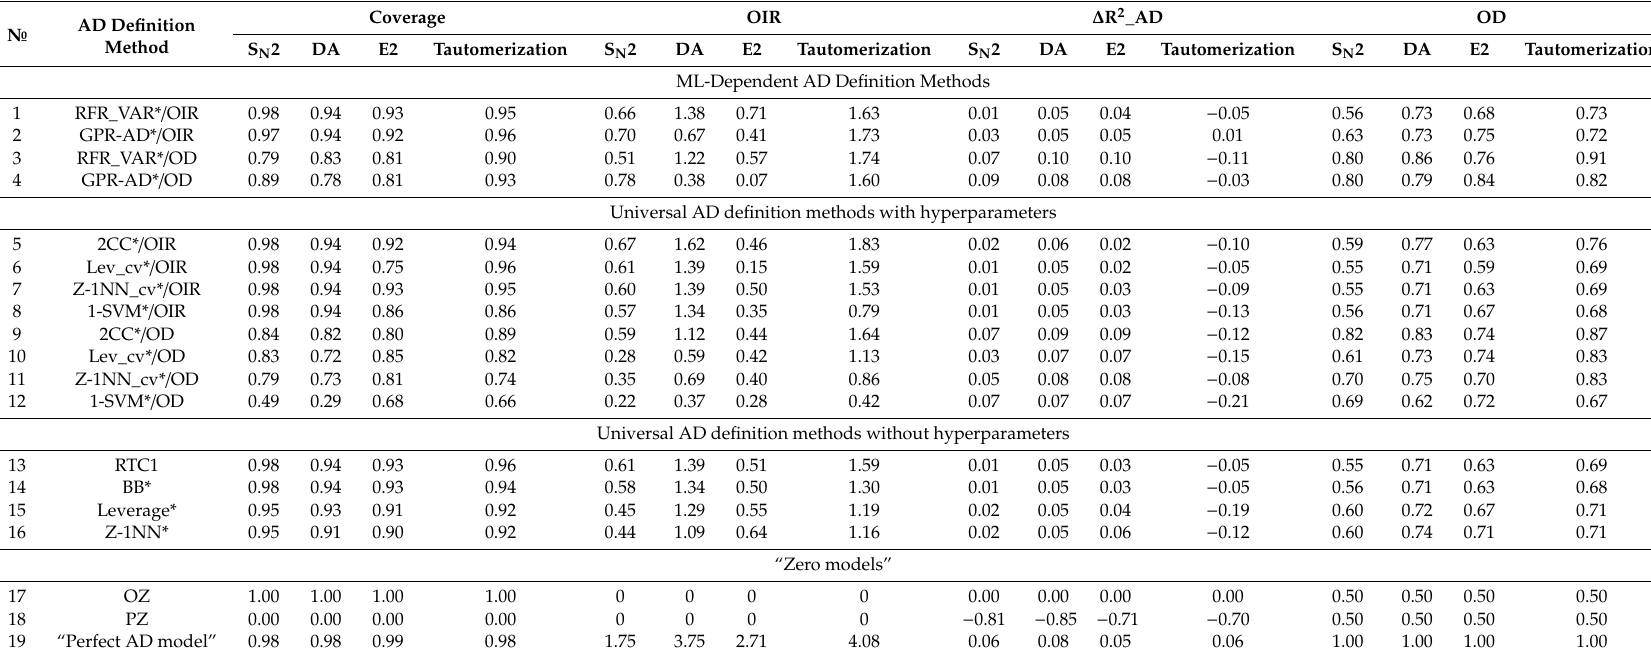
Table 3. Values of four AD performance metric for four datasets for the composite AD definitions assessed using nested cross-validation with hyperparameters tuned in its inner